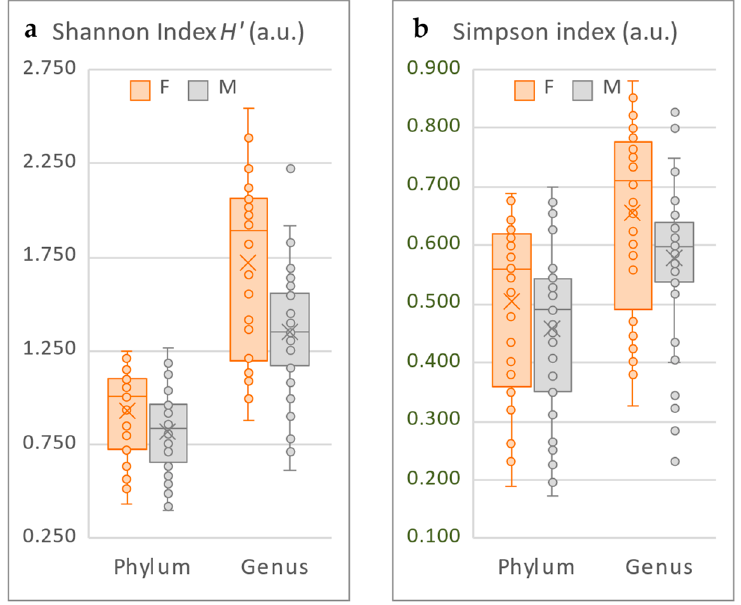
Figure 3. Graphic representation of the α -diversity at the phylum and genus taxonomic levels, calculated using the Shannon ( a ) and Simpson ( b ) indices. a.u. = arbitrary unit. Table 2. Values of interest at the phylum and genus levels, calculated from Shannon and Simpson